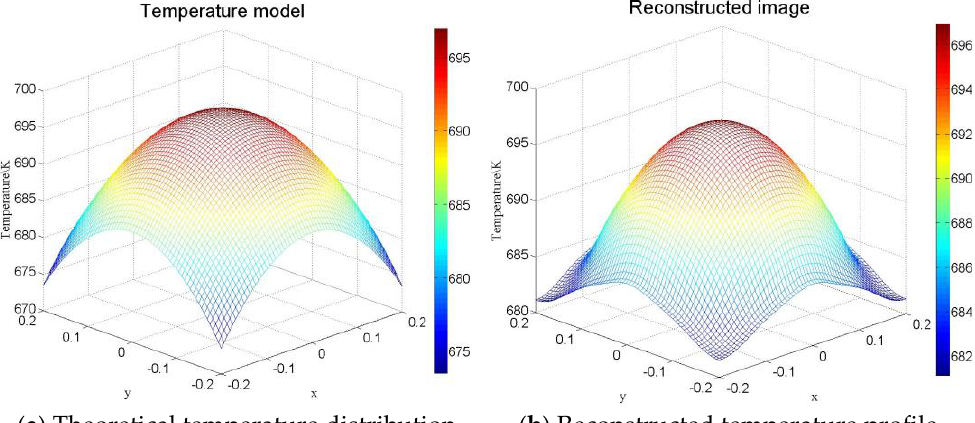
Figure 5 . Central – symmetric temperature distribution (Model I). Figure 5. Central–symmetric temperature distribution (Model